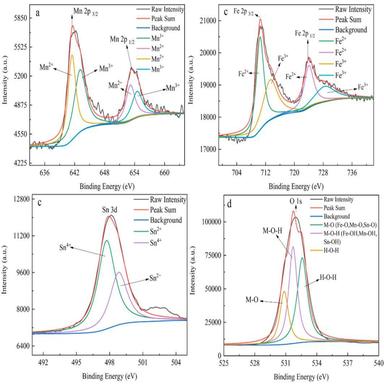
XPS Mn 2P spectrum (a), Fe 2P spectrum b), Sn 3d spectrum (c), and O 1S spectrum (d) of waste coal cinder.